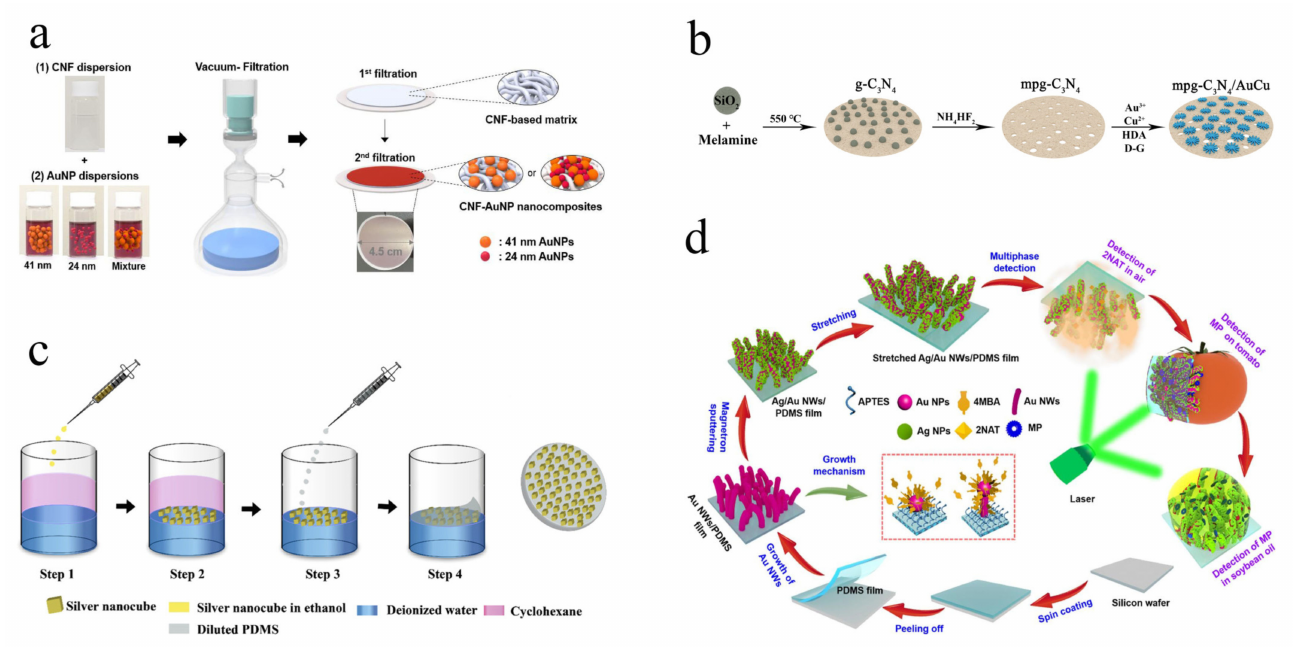
Figure 2. Schematic fabrication of CNF-AuNP membrane substrate ( a ). © 2022 Elsevier B.V. Adapted with permission from [42]. Schematic illustration of preparation principle of mpg-C 3 N 4 /AuCu membrane ( b ). © 2022 Elsevier B.V. Adapted with permission from [45]. Schematic illustration